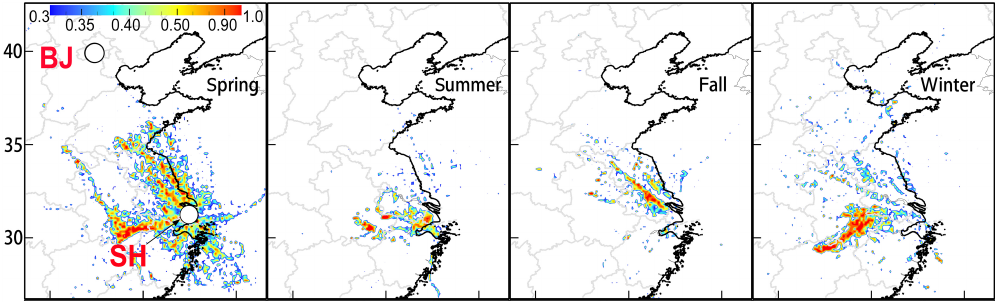
Figure 15. The potential source contribution function (PSCF) of OC during four seasons in 2014 in Shanghai. The cities marked in the leftmost panel are Beijing (BJ) and Shanghai (SH). The color scales indicate the values of